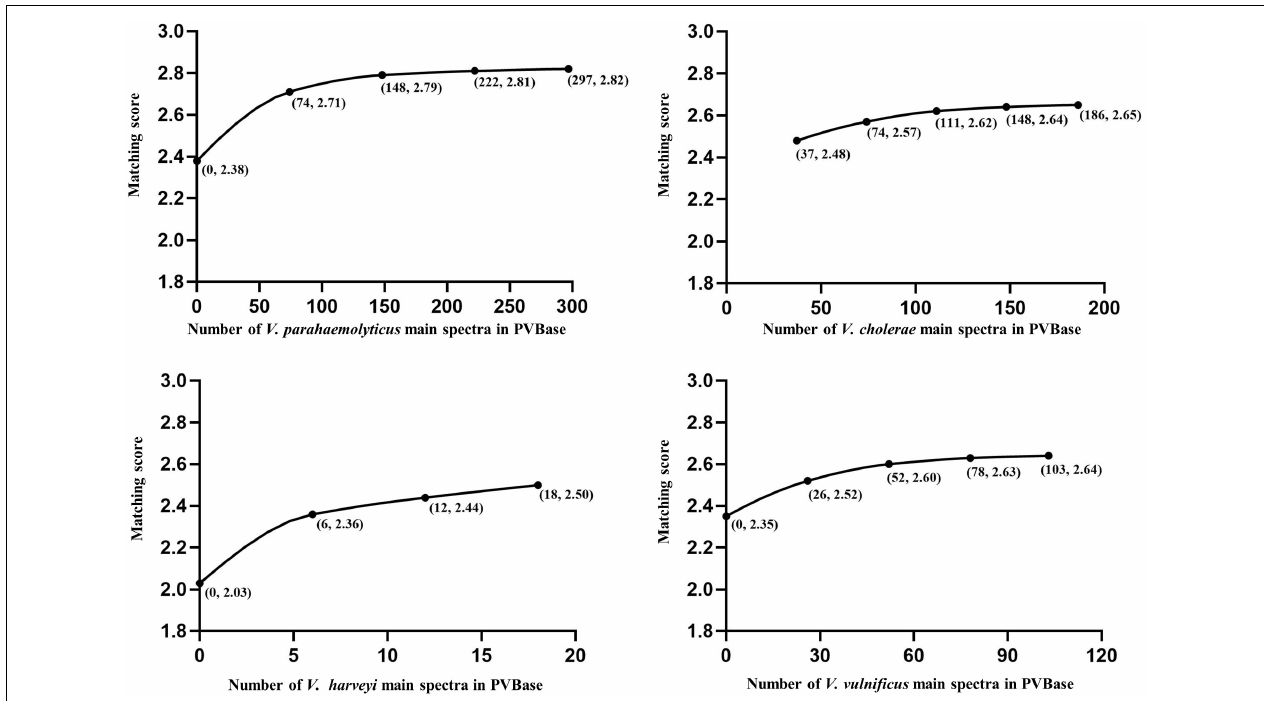
FIGURE 2 | Correlations between the number of main spectra filed in PVBase and expected mean of highest matching scores. Data for V. parahaemolyticus , V. cholerae , and V. vulnificus are provided as examples. Numbers in parentheses below points represent the number of strains added in a single addition and the matching score.